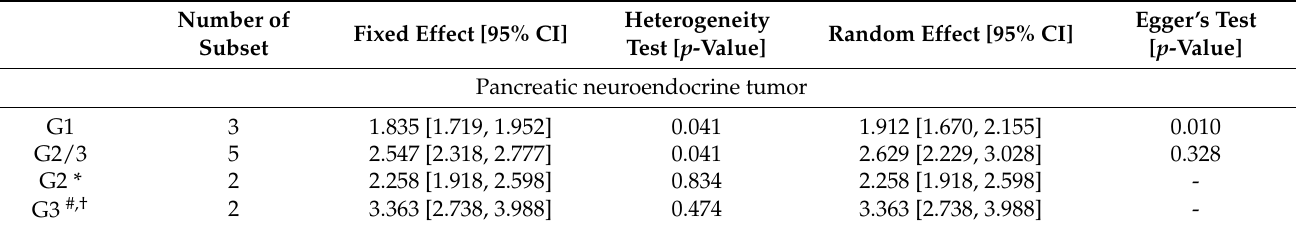
Table 3. Mean value of the neutrophil-to-lymphocyte ratio (NLR) in pancreatic neuroendocrine